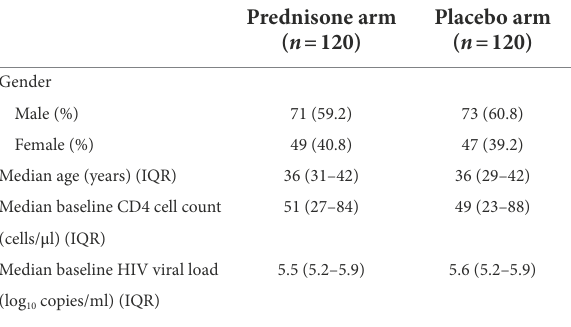
TABLE 1 Baseline characteristics ( N =